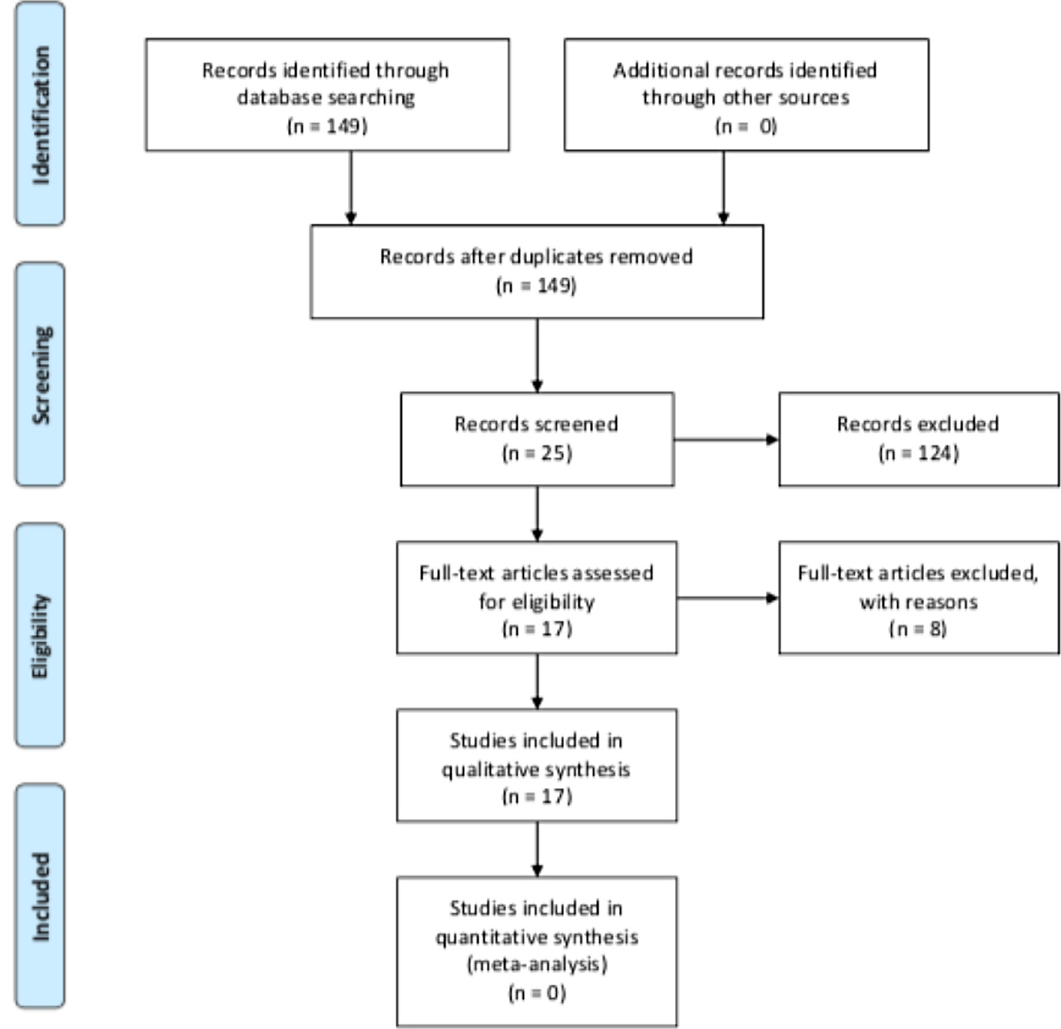
Fig. 1. Flow diagram of the screened